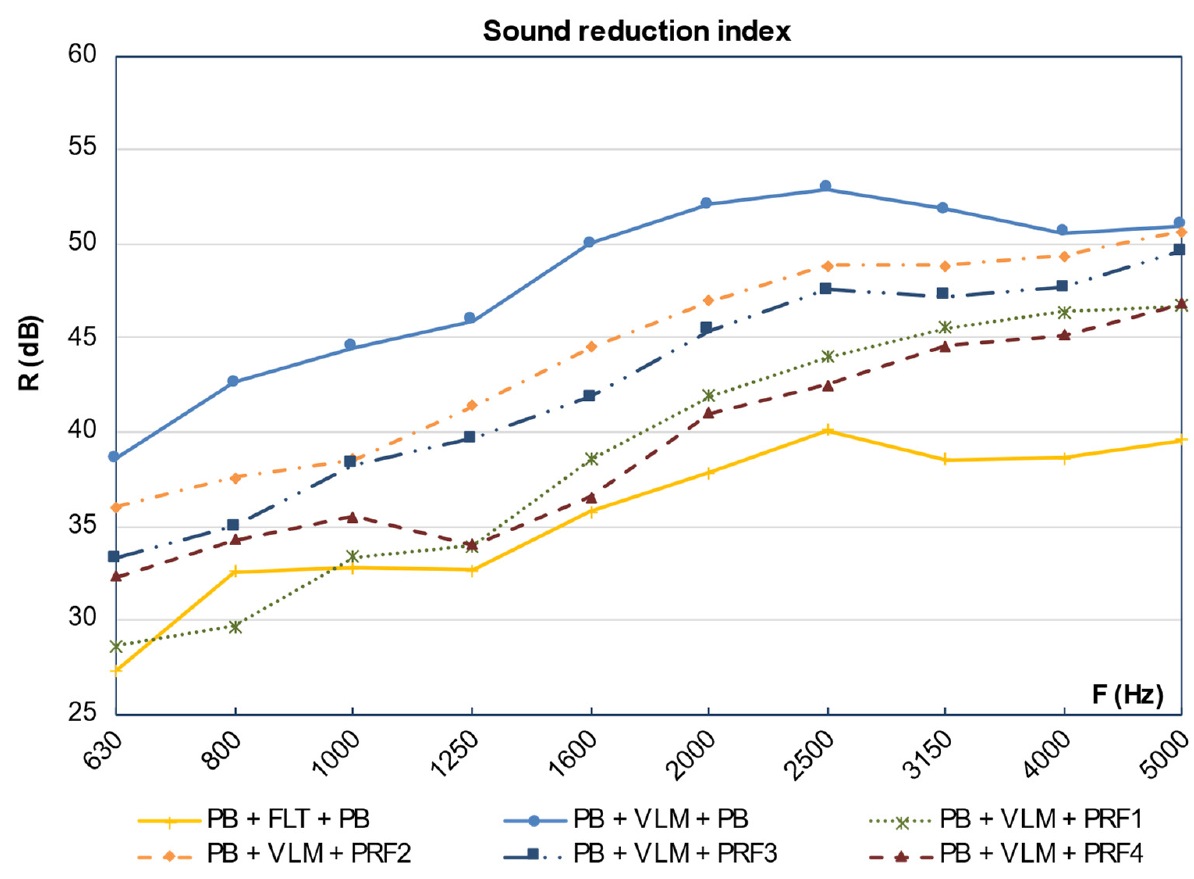
Figure 7. Sound reduction index, R (dB), of the assessed configurations.